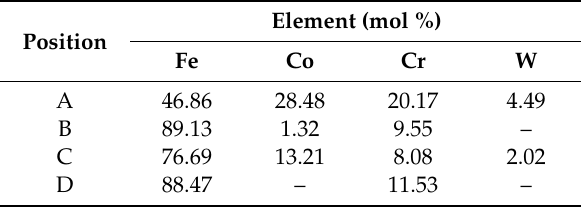
Figure 4. Photos of the microstructure around the boundary between Stellite alloy and F91 steel of sample ( a ) #1 and ( b ) #2. Table 2. The major composition in different positions around the boundary between Stellite alloy and F91 steel.